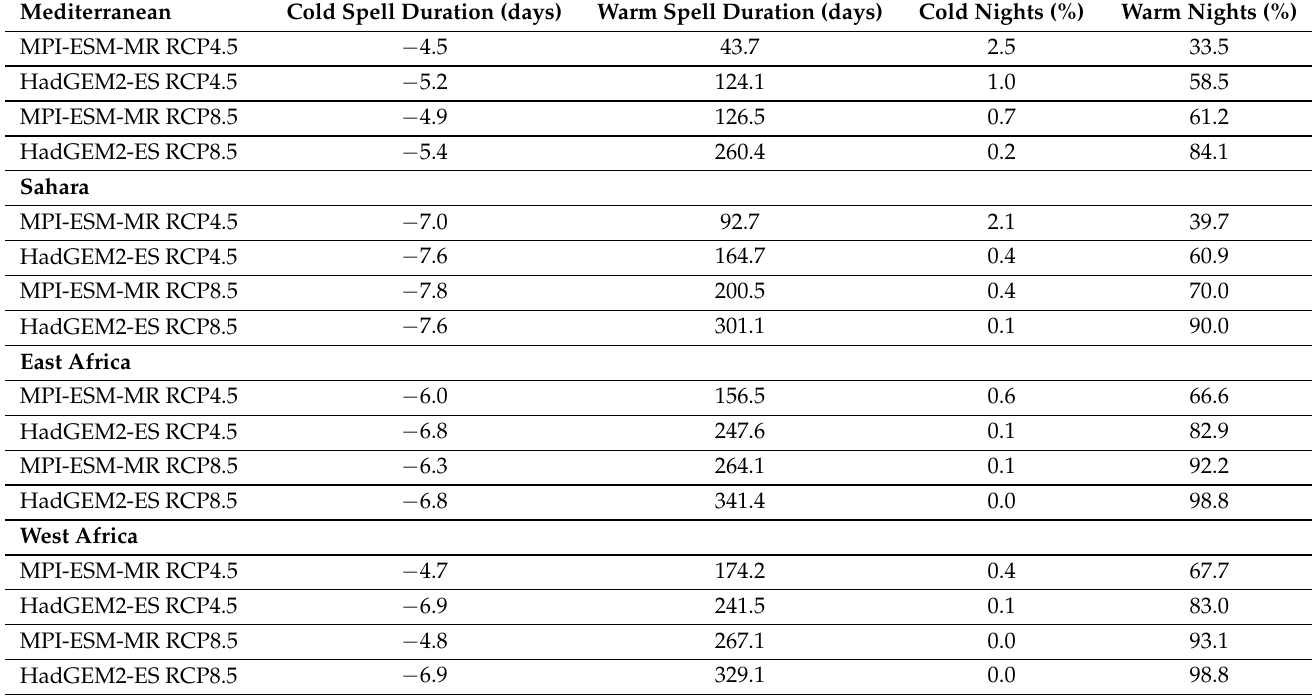
Table 3. The temporally averaged changes in cold spell and warm spell duration and cold nights and warm nights index weighted over sub-regions of MENA for the period of 2071–2100 displayed as differences with respect to the reference period